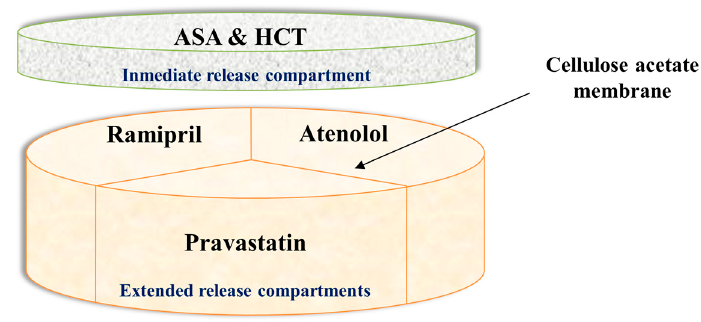
Figure 9. 3D printed polypill. Modified from reference [3].